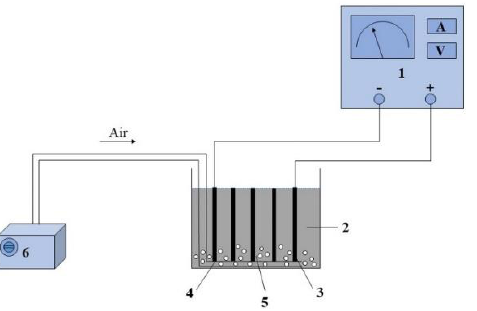
Figure 2. Schematic of the E-Fenton process set up. ( 1 ) High-frequency pulse stabilized DC power supply, ( 2 ) the E-Fenton cell, ( 3 ) anode, ( 4 ) cathode, ( 5 ) iron plates, and ( 6 ) air